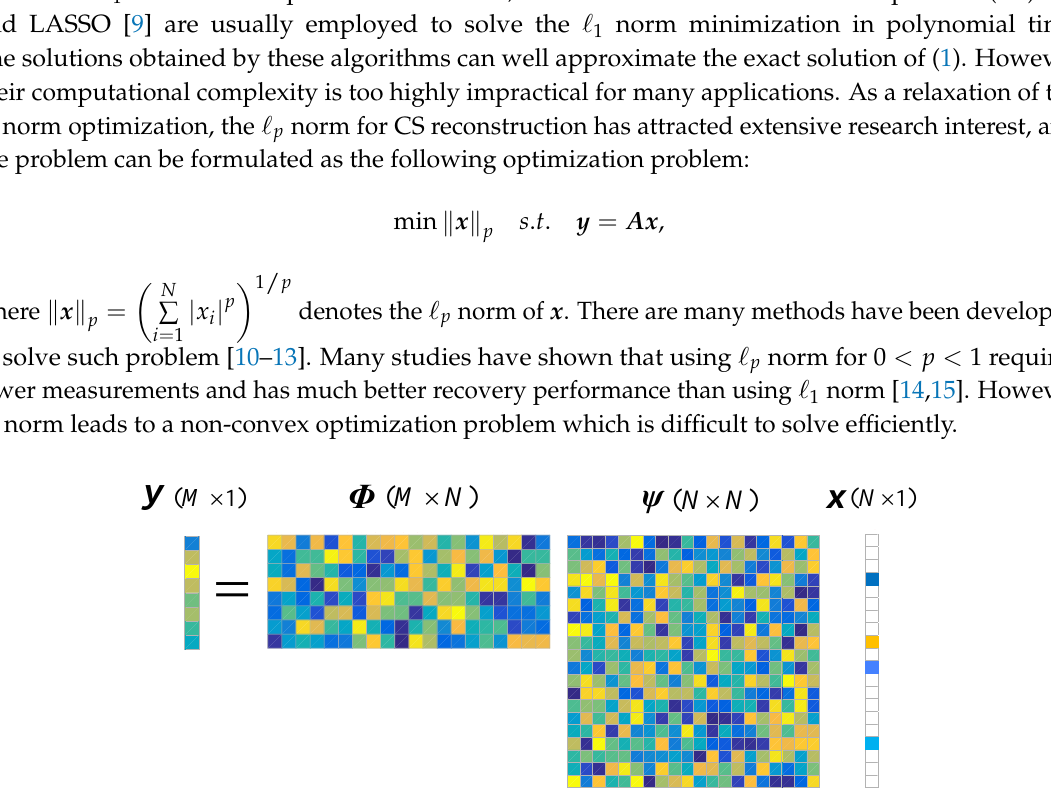
Figure 2. Compressed Sensing model with s =